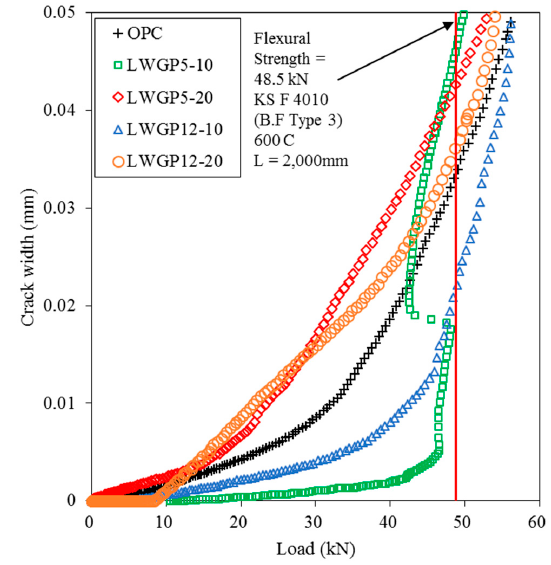
Figure 10. Relationships of the LWGP concrete flume between the crack widths and the loads.